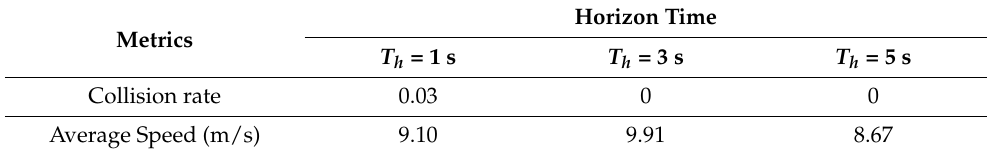
Figure 9. Comparison of the episode reward in the training for the different forward predictive horizons. Table 3. Performance comparison for the different forward predictive